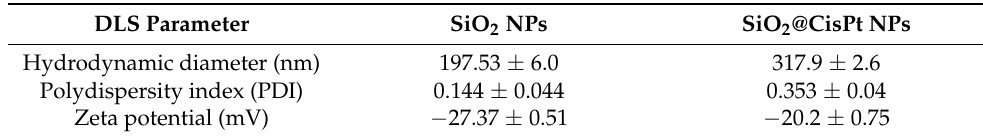
Table 3. Hydrodynamic diameter, polydispersity index (PDI), and zeta potential values for SiO 2 NPs and SiO 2 @CisPt NPs in water.